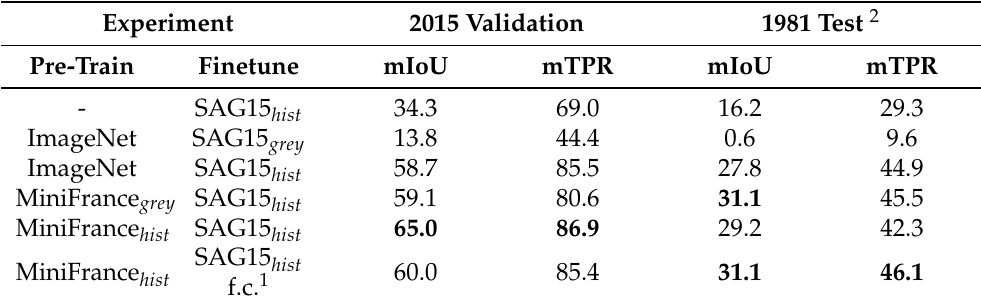
Table 4. Summary of the multiclass semantic segmentation results on the Sagalassos (SAG) 2015 validation set and 1981 test set. All experiments use the UNet-EffB5 architecture. ‘-grey’ means manual RGB → HIST conversion, ‘-hist’ (=historical) means learned mapping with CycleGAN.